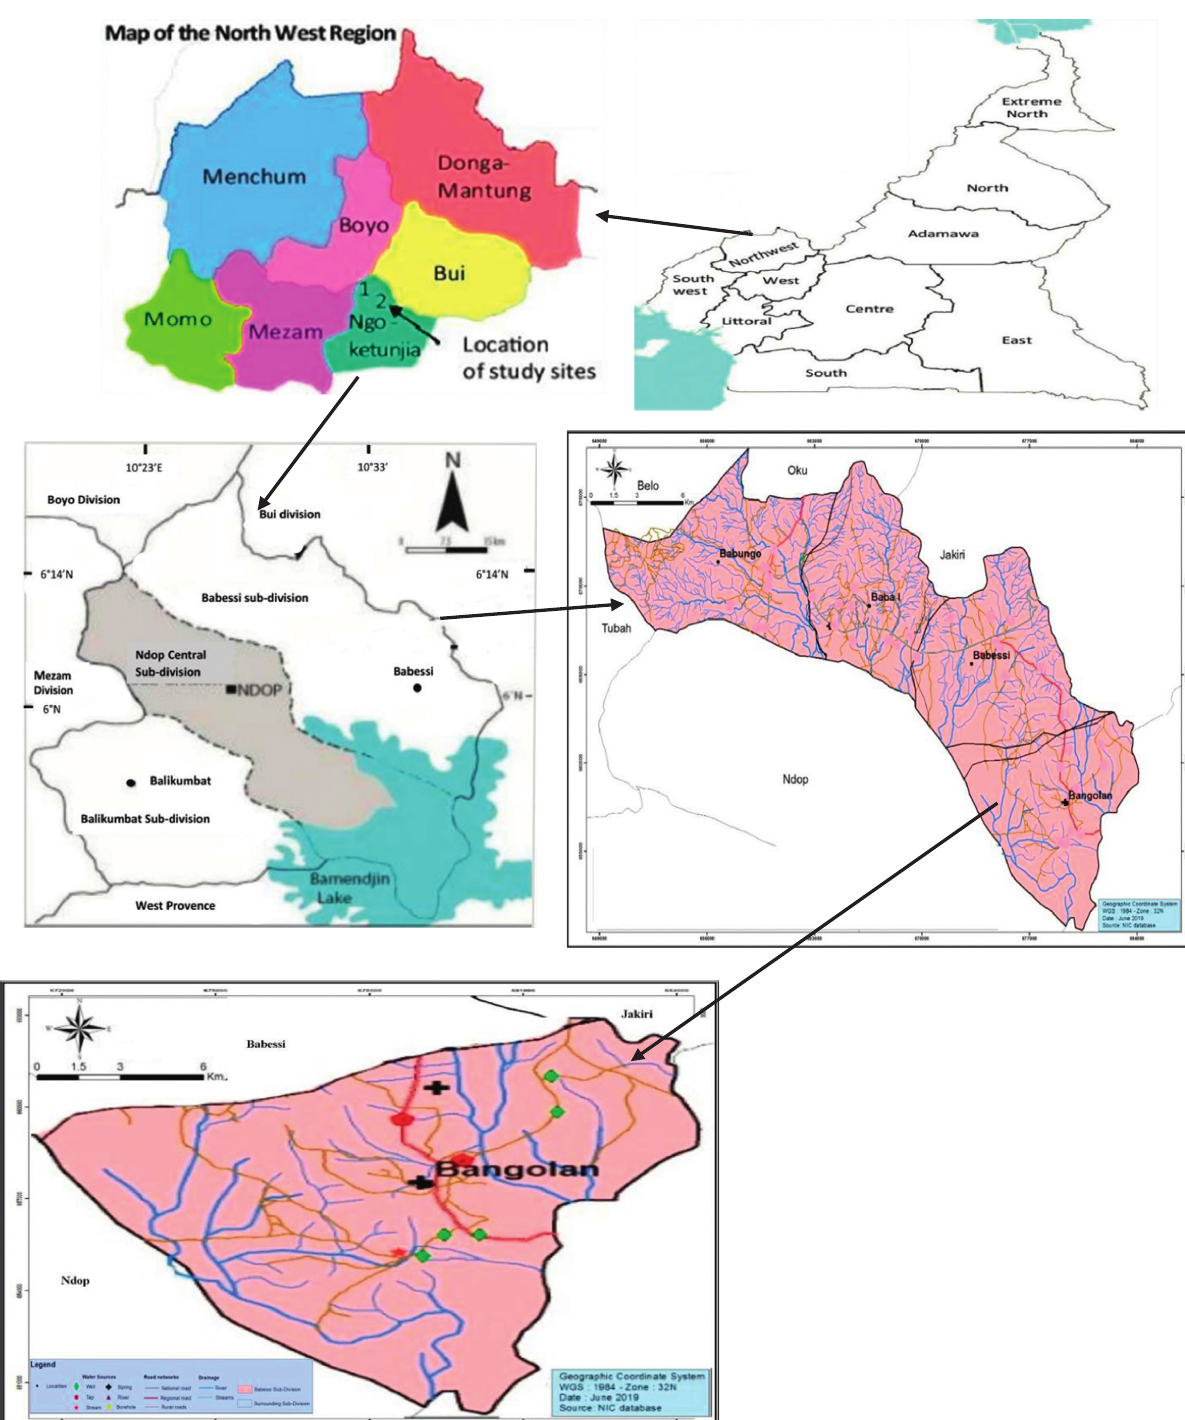
Figure 1: Map of the study area: (a) map of Cameroon, indicating the map of northwest region; (b) map of northwest region indicating the map of Ngo- Ketunjia; (c) map of Ngo-Ketunjia indicating the map of Babessi subdivision; (d) map of Babessi subdivision indicating the map of Bangolan; (e) map of Bangolan showing the sampling